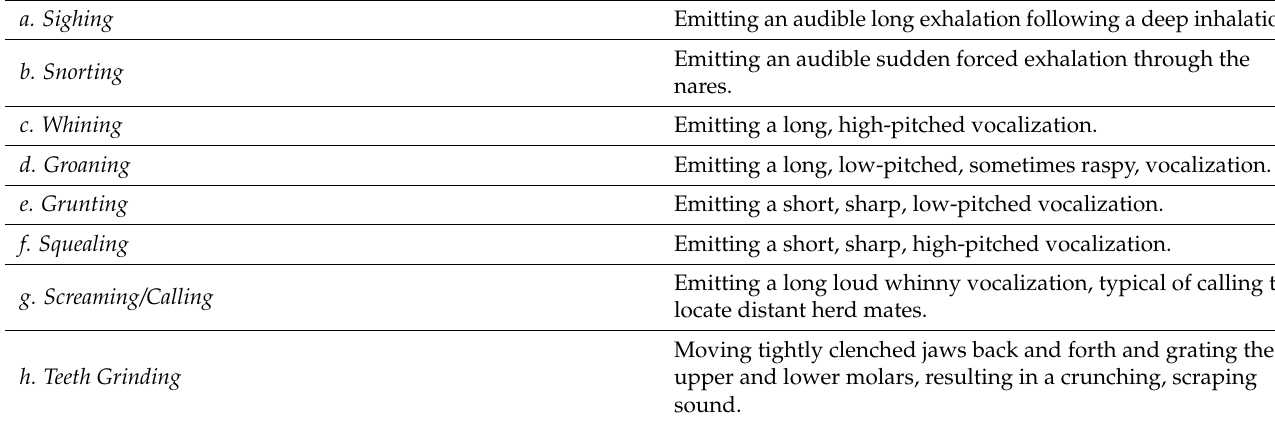
Table 8. Vocalizations/audible